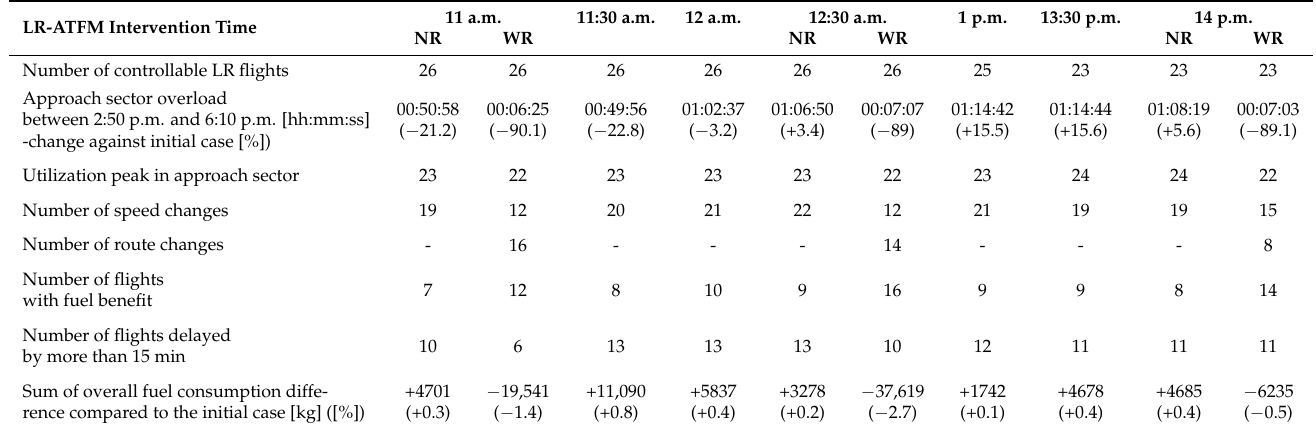
Table 1. Impact of Long-haul speed adjustments and route changes during cruising on a balanced distribution of arrivals to WSSS. The sooner speed adjustments take place, the smaller the approach sector overload. Alternative routes (WR) enable aircraft to both shift the arrival time and save